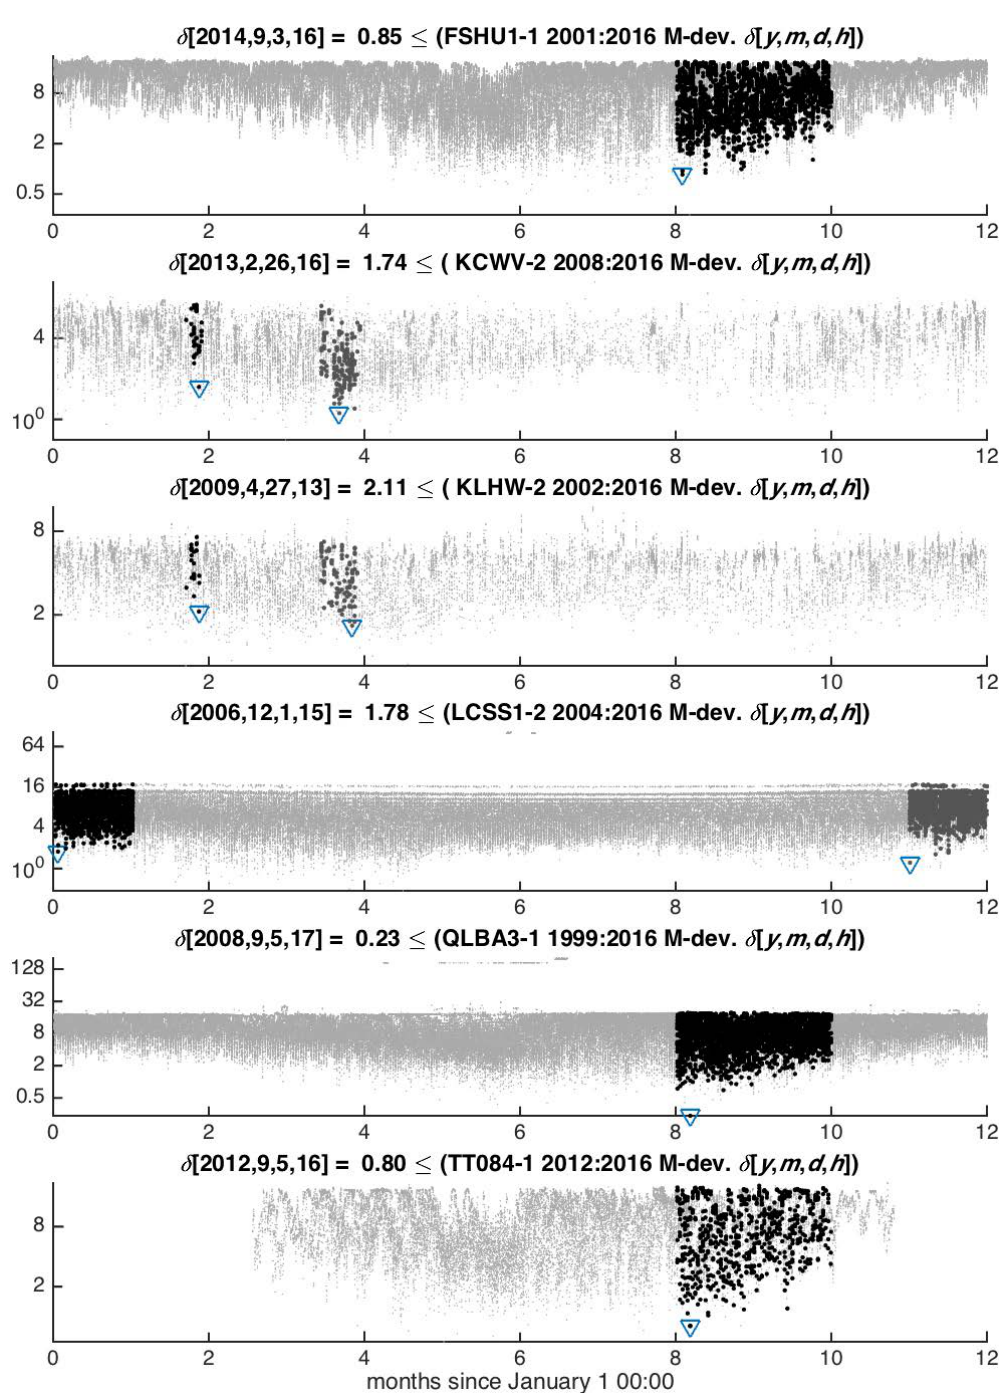
Figure 1. Time series of Mahalanobis (standardized) deviation norm (cid:107) δ t (cid:107) for each station (6 rows). Points for states that do and do not meet burn requirements are dark and light gray, respectively. For each station, the most typical day in the burn window has the smallest (cid:107) δ t (cid:107) and is listed in the title and indicated with a (cid:79) marker. The abscissa is t ( mod 12 ) for all the years indicated in the plot